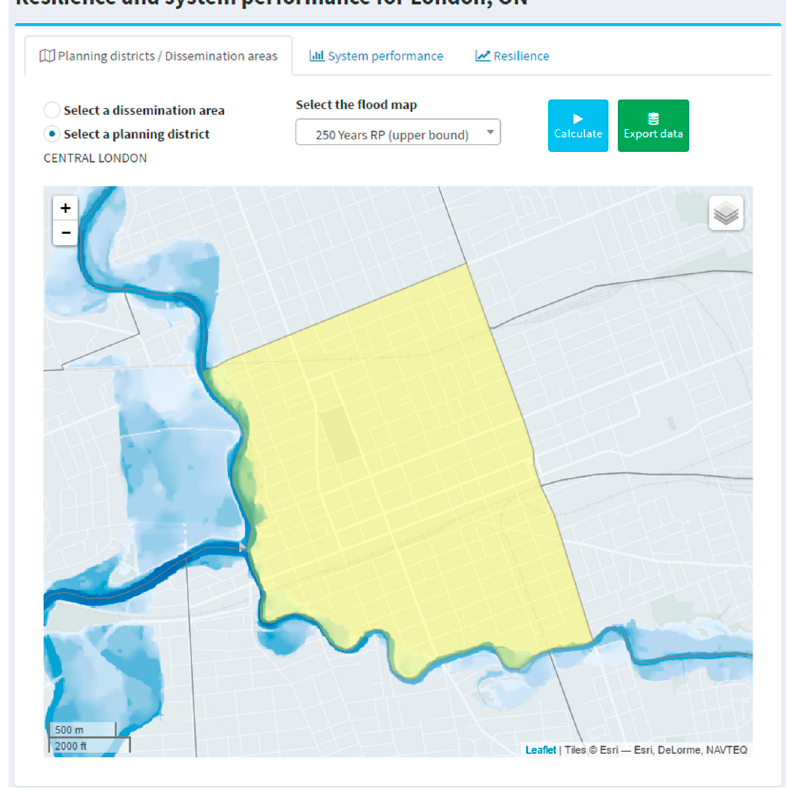
Figure 14. Planning District and flood inundation map selection for the city of London.